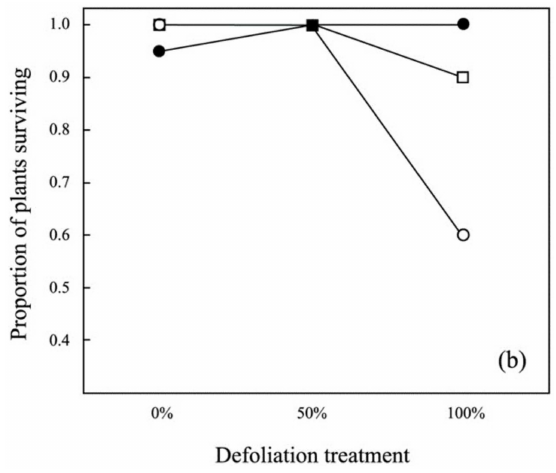
Figure 3. Effects of artificial defoliation treatments on the survival of understory herbs in different light levels for forest edge species Costus malortieanus and Goeppertia marantifolia ( a ) and forest understory species Goeppertia micans and Heliconia irrasa ( b ). See text for details of experimental treatments.